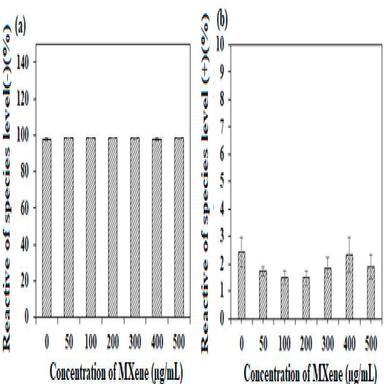
The intracellular ROS levels (− ) and (+) after 24 h of exposure to different concentrations of the Ti2CTx MXenes on HeLa cells in 2D cell culture.